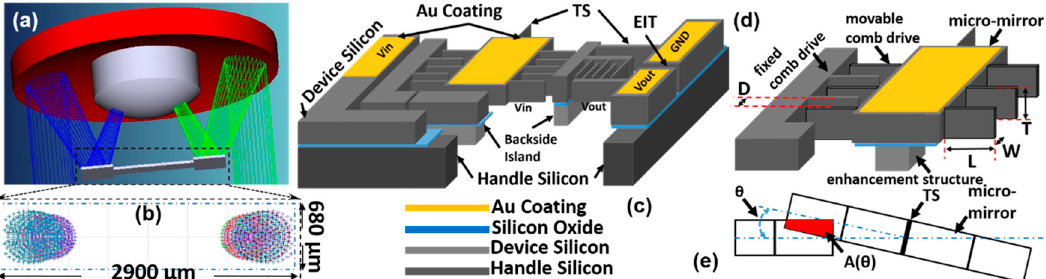
Figure 2. Schematic drawing of the 2D patterned Au-coated resonant micro-scanner and its electrical layout. ( a ) CAD drawing of the scanning micro-mirror inside the confocal microscope’s scan-head (OD: 5.0 mm). ( b ) Zoom-in view of the ray-tracing beam spots (changes due to axial scanning, 0–400 µ m), e ff ective area of the “dumbbell” shaped micro-mirror. ( c ) Schematic drawing of the device silicon / buried oxide / handle silicon layers (not to scale), in-plane comb-drive actuator fingers, Au coating, inner and outer torsion springs, electrical insulation trenches, gimbal frame, backside island, and electrical layout, not to scale Note: EIT, electrical insulation trench; TS, torsion spring. ( d ) Schematic drawing of the fixed and movable comb-drive actuator fingers, D: the distance (or gap) between the comb-drive actuator fingers, W: width, L: length. ( e ) Schematic drawing of the actuation using the in-plane comb-drive actuator fingers, θ : tilting angle, A( θ ): overlapped